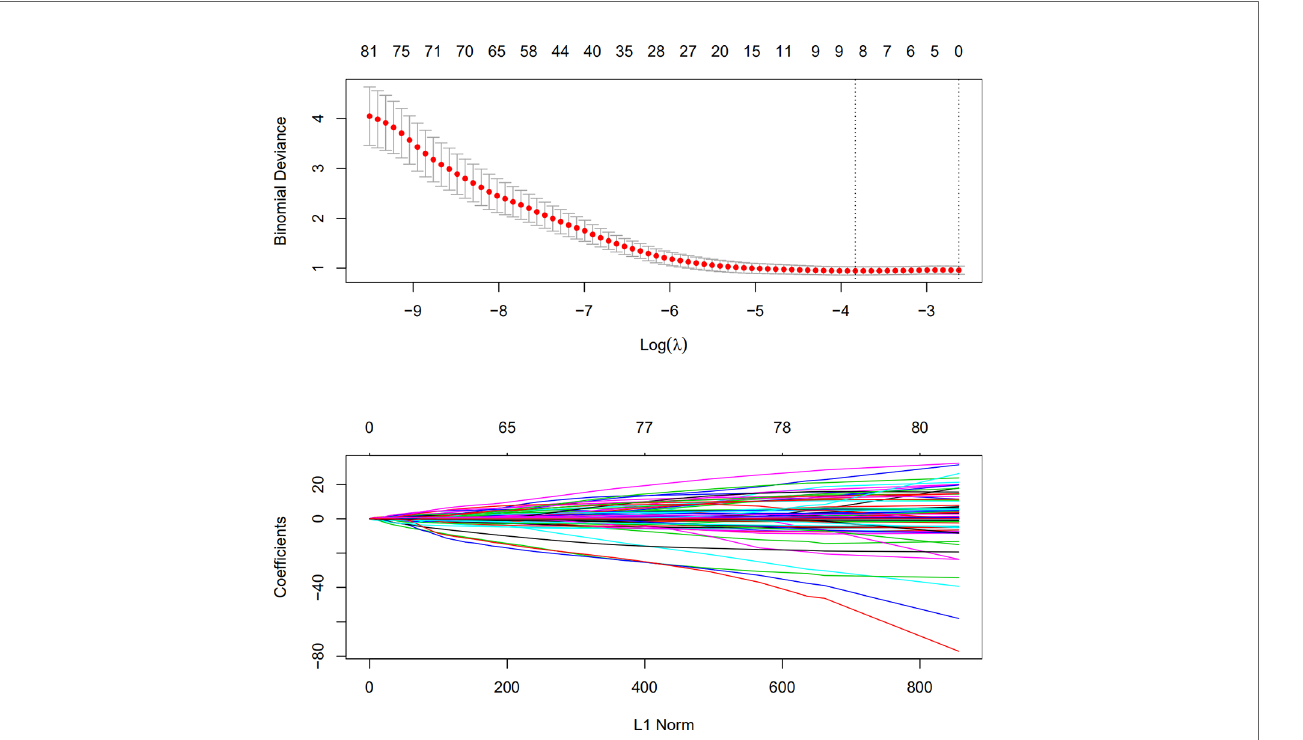
FIGURE 1 | Lasso regression for splenic characteristics in the training group. Characteristics with a logistic regression p-value of <0.05 were used for lasso regression modeling. A lambda (Ln) was selected at − 3.833 for the fi nal lasso